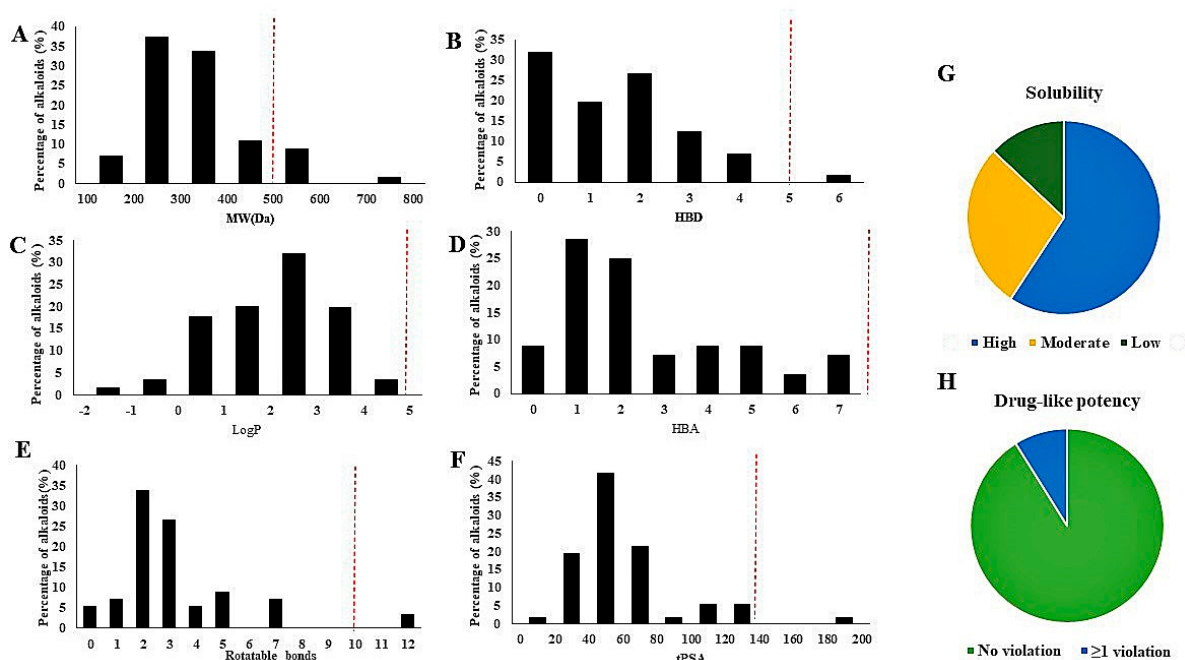
Figure 5. Analysis of physicochemical properties of alkaloids: ( A ) molecular weights (MW(Da)); ( B ) hydrogen bond donors (HBDs); ( C ) calculated LogP; ( D ) hydrogen bond acceptors (HBAs); ( E ) rotatable bonds; ( F ) topological polar surface area (TPSA); ( G ) solubility; ( H ) Drug-like potency.